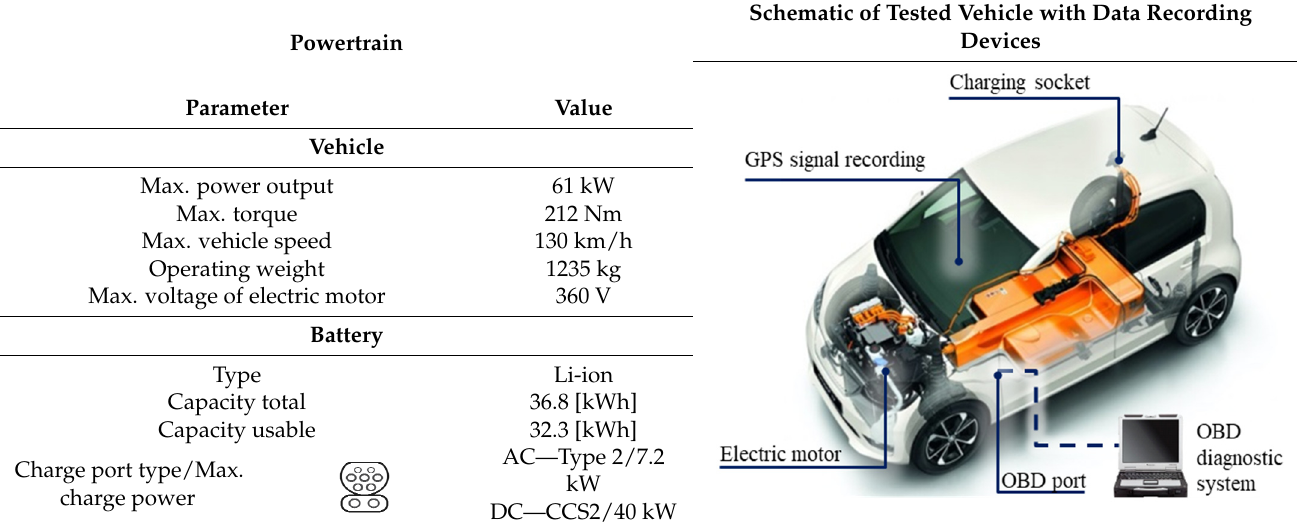
Table 2. Technical data of the analyzed powertrain fitted in ŠKODA CITIGO e iV [51].